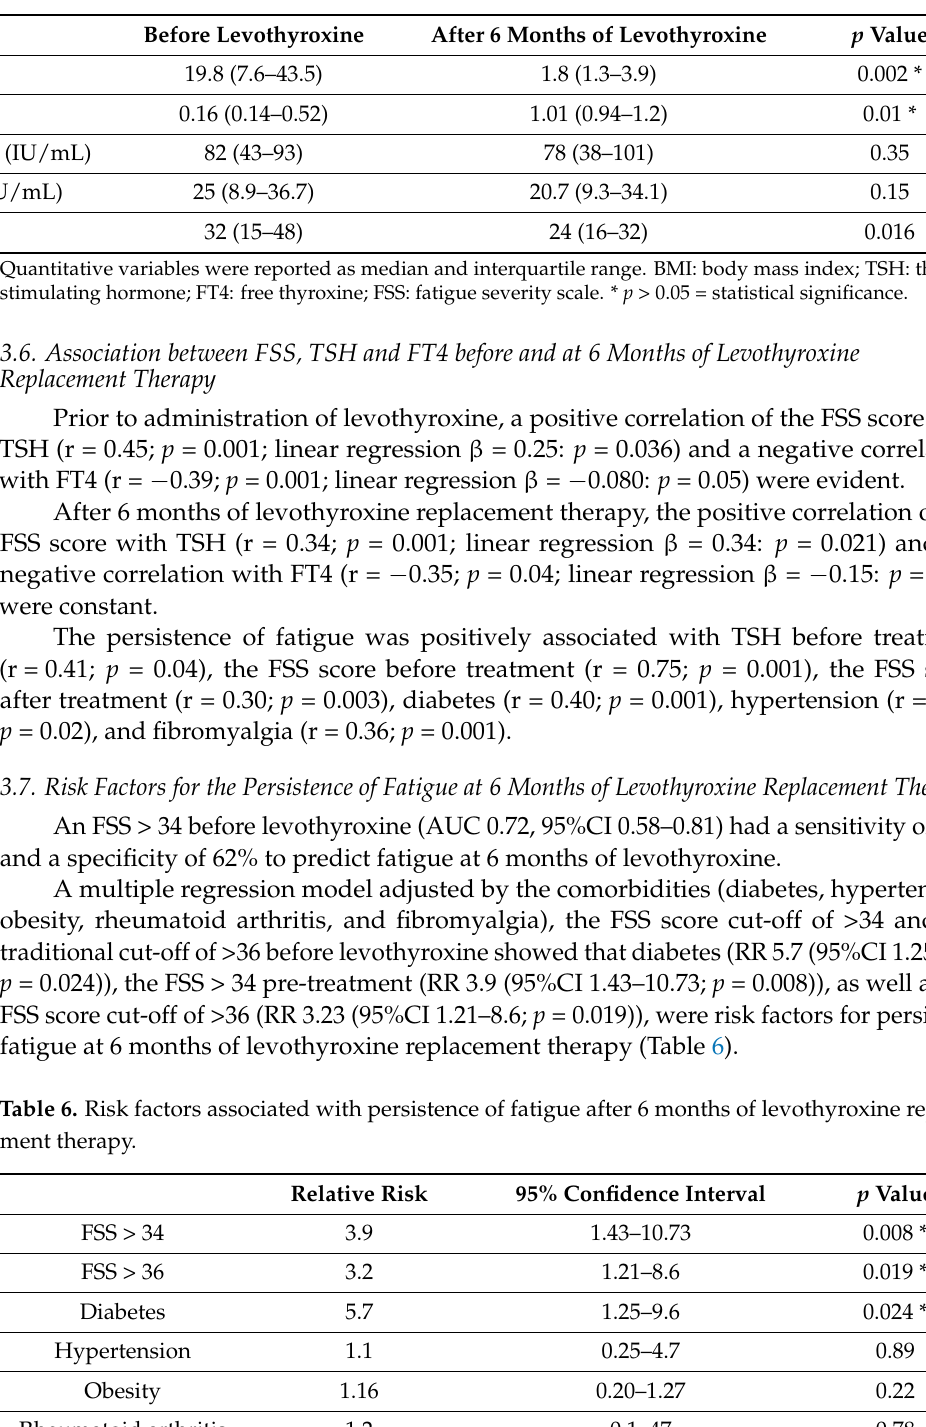
Table 5. Biochemical characteristics of patients with autoimmune hypothyroidism before and after 6 months of levothyroxine replacement therapy.